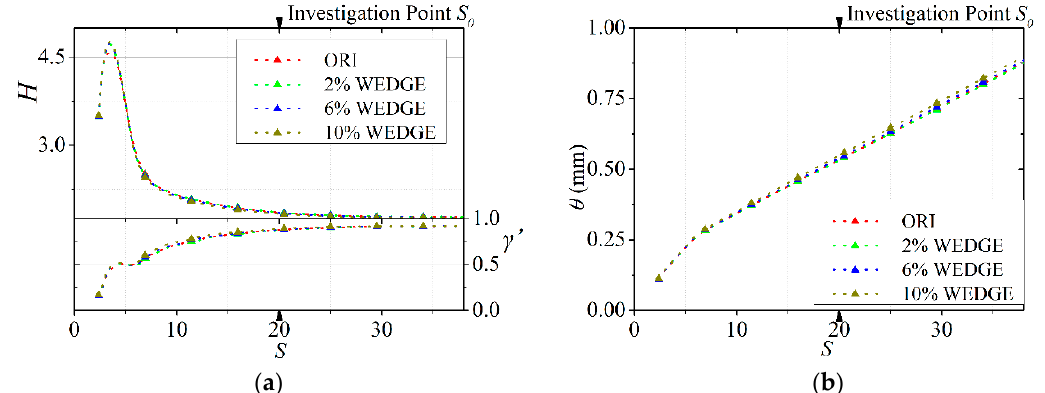
Figure 10. The WEDGE of Ellip.LE at Tu = 7%: ( a ) the boundary layer shape factor and normal average turbulence intermittency; ( b ) the momentum thickness along the aerofoils.